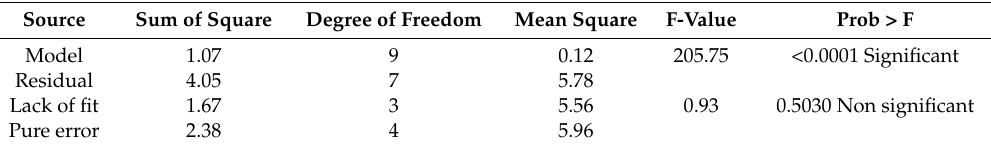
Table 7. ANOVA for the fitted quadratic polynomial model of BA